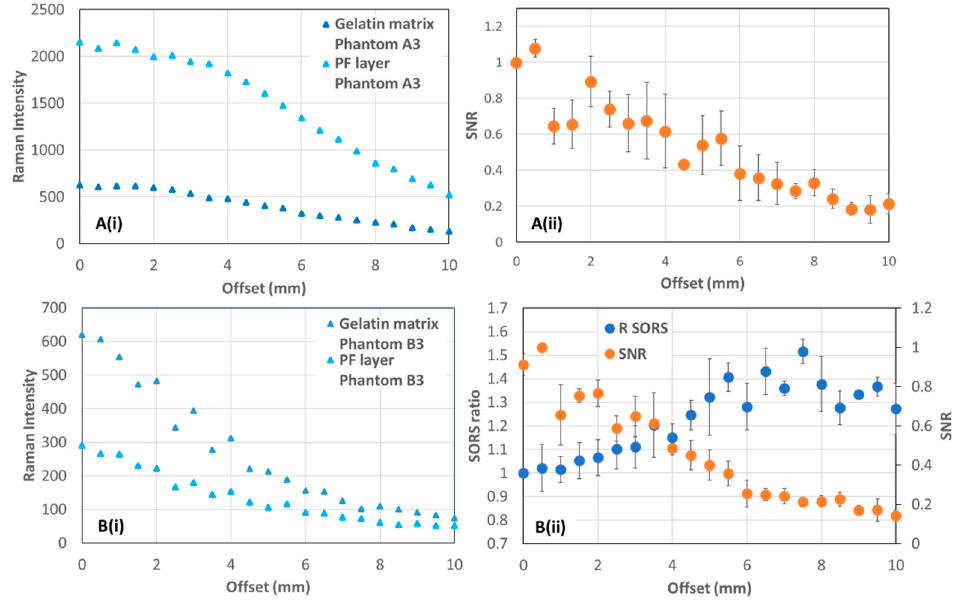
Figure 3. (i) Representative Raman signal of top and bottom layer with offset for Phantoms type A and B (Panel A(i) and B(i) respectively). (ii) SNR versus offset for Phantoms type A and SORS and SNR versus offset for Phantoms type B (Panel A(ii) and B(ii) respectively). SORS ratio values were normalized to the respective zero offset value for convenience.